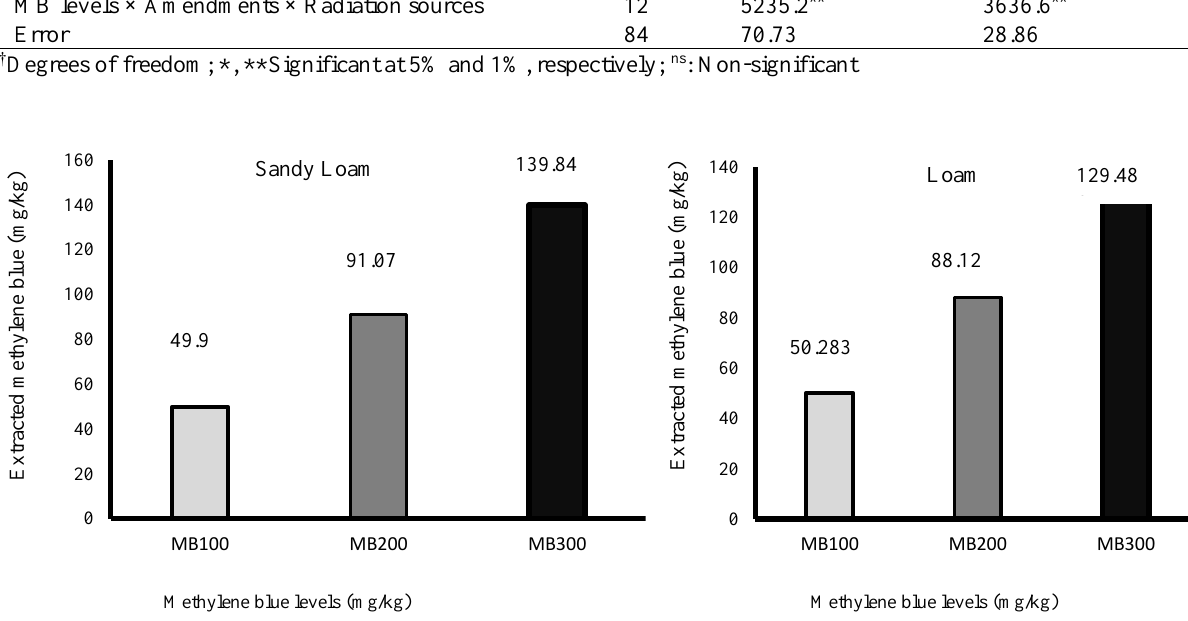
Mean squares Sandy loam Loam